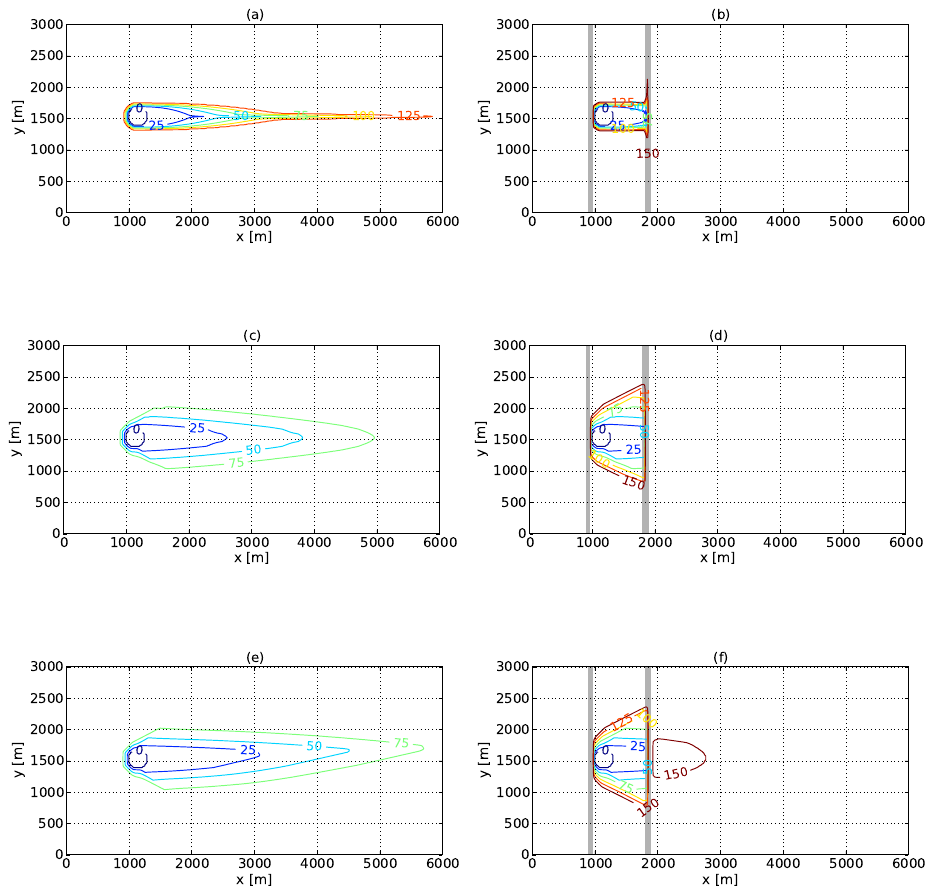
Figure 2. The same as in Fig. 1, but when the mean wind velocity and the fire intensity are U t =6.70ms − 1 and I =30000kWm − 1 (case B Fig. 2. The same as in Fig. 1 but when the mean wind velocity and the fire intensity are U t = 6 . 70ms − 1 and I = 30000kWm − 1 (case B ).